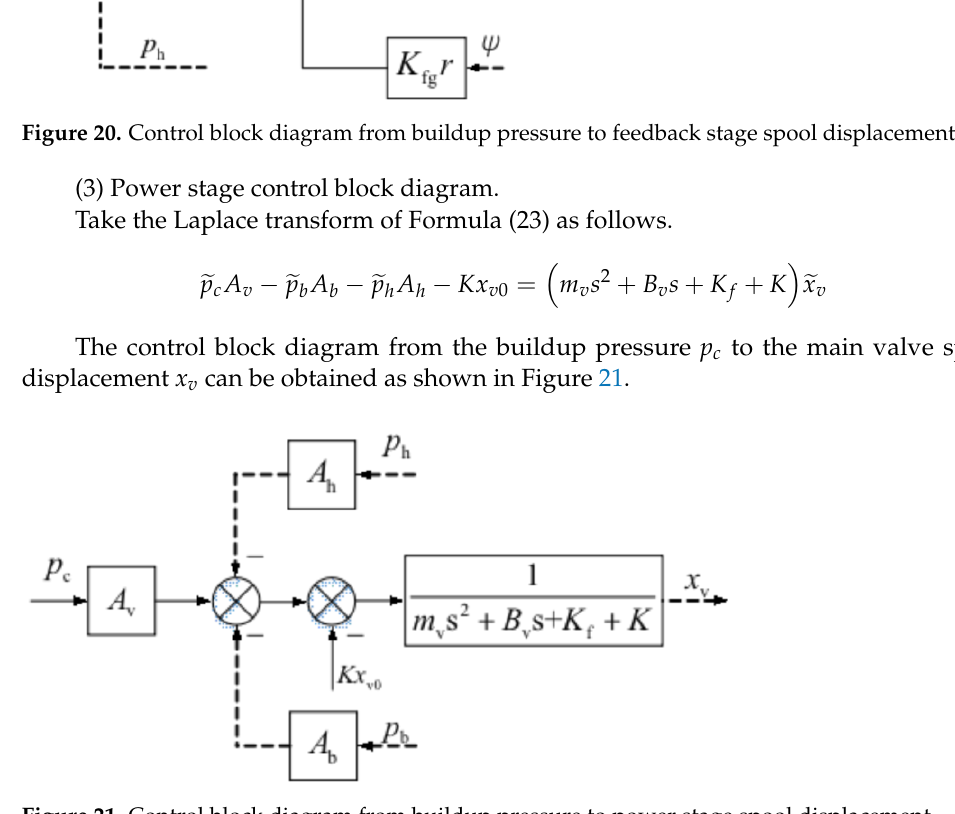
Figure 19. Control block diagram from control current to buildup pressure.